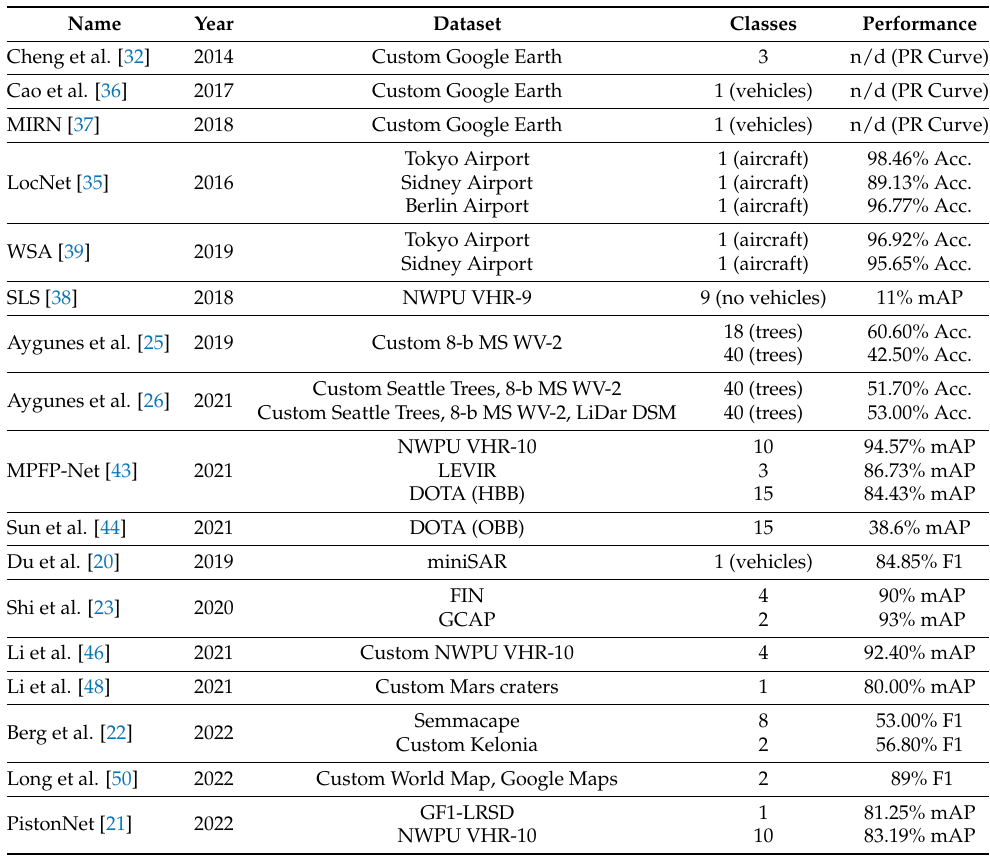
Table 7. Results of surveyed methods evaluated on specific datasets. Works are sorted by year and grouped when using similar datasets. For each method, the used dataset, number of classes, and performance are reported. Performance metrics are: PR curve (no value), accuracy, F1 score, and mean average precision